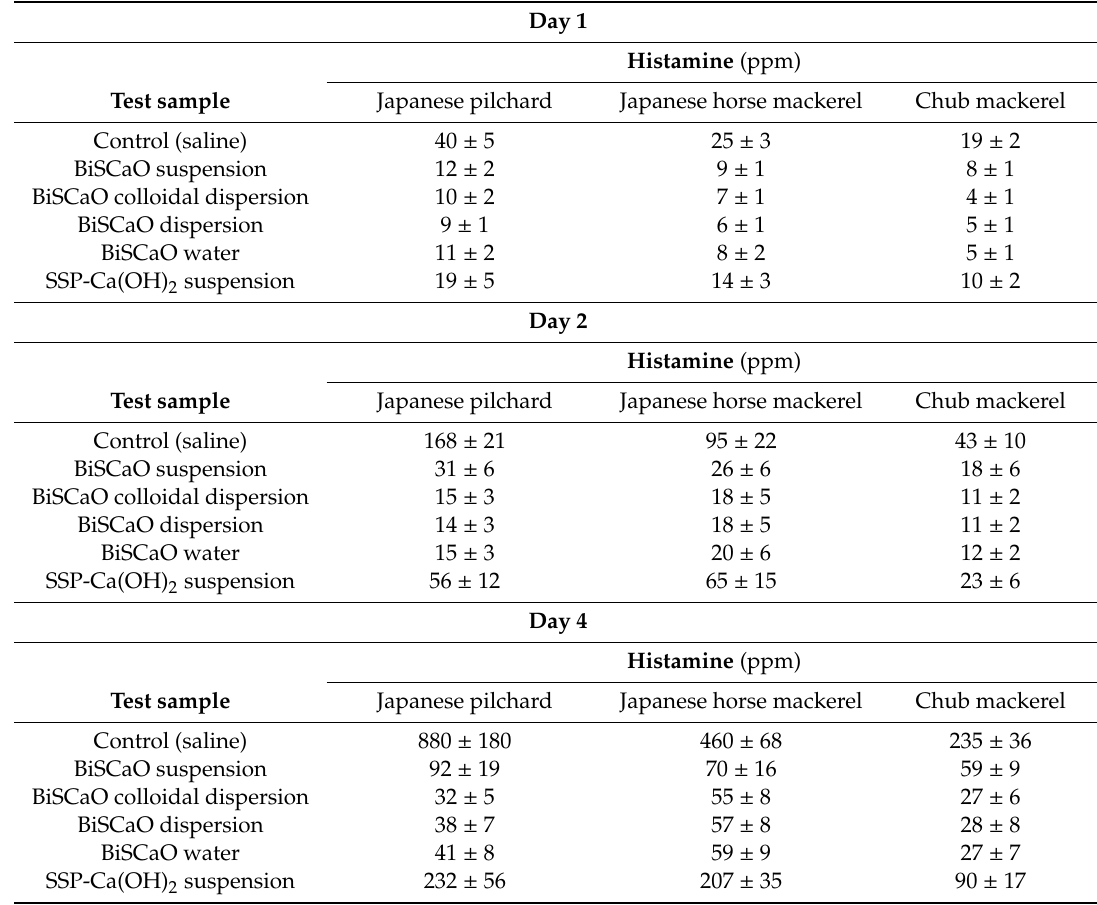
Table 3. Reduction of histamine in Japanese pilchard, Japanese horse mackerel, and chub mackerel after cleaning with various BiSCaO-based disinfectants ( n =